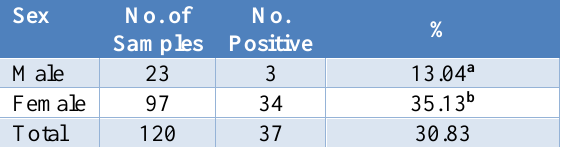
Table, 2: Infection rate with B. sulcata according to sex in sheep.